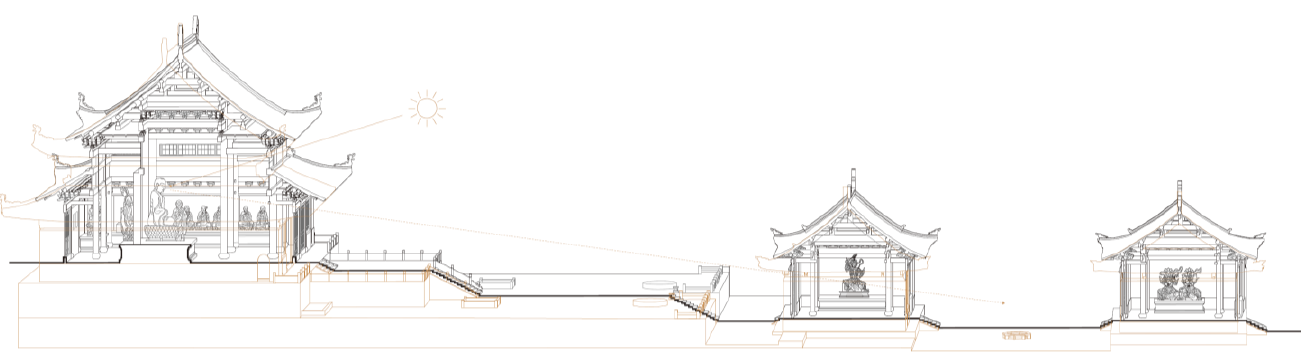
Figure 23. Axonometric section of the Three Temples.